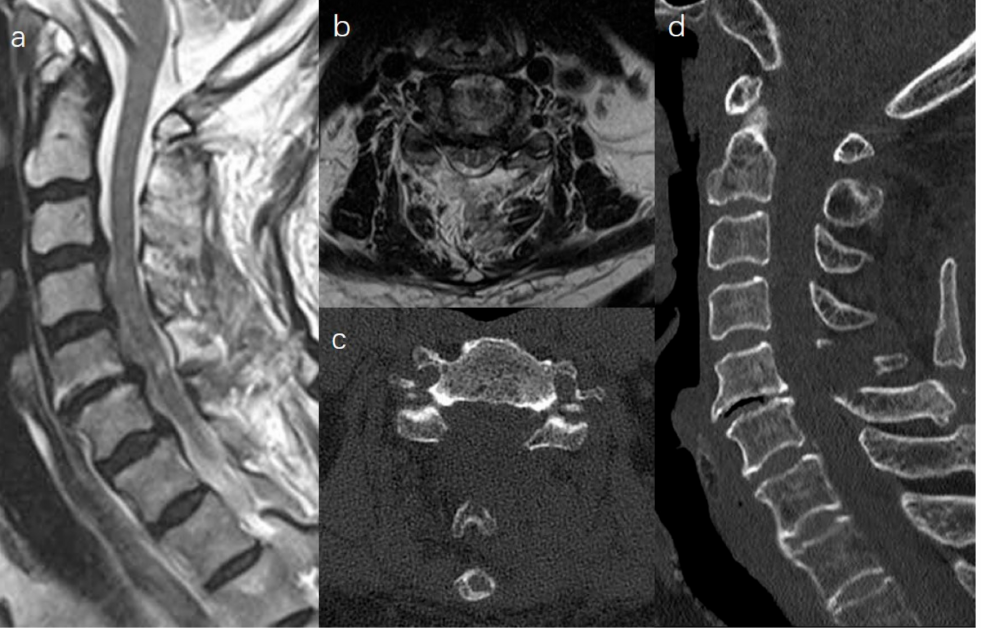
Figure 5. Postoperative MRI showed hypertrophied LF was removed ( a , b ). A CT scan revealed that laminectomy was performed, while PTB and cervical lordosis were preserved ( c , d